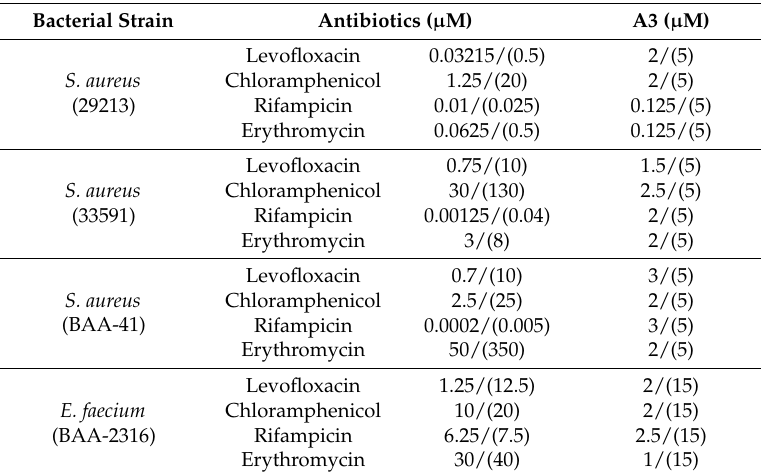
Table 4. Synergistic activity of A3 in combination with conventional different strains of standard and MDR bacteria. Results represent triplicates.